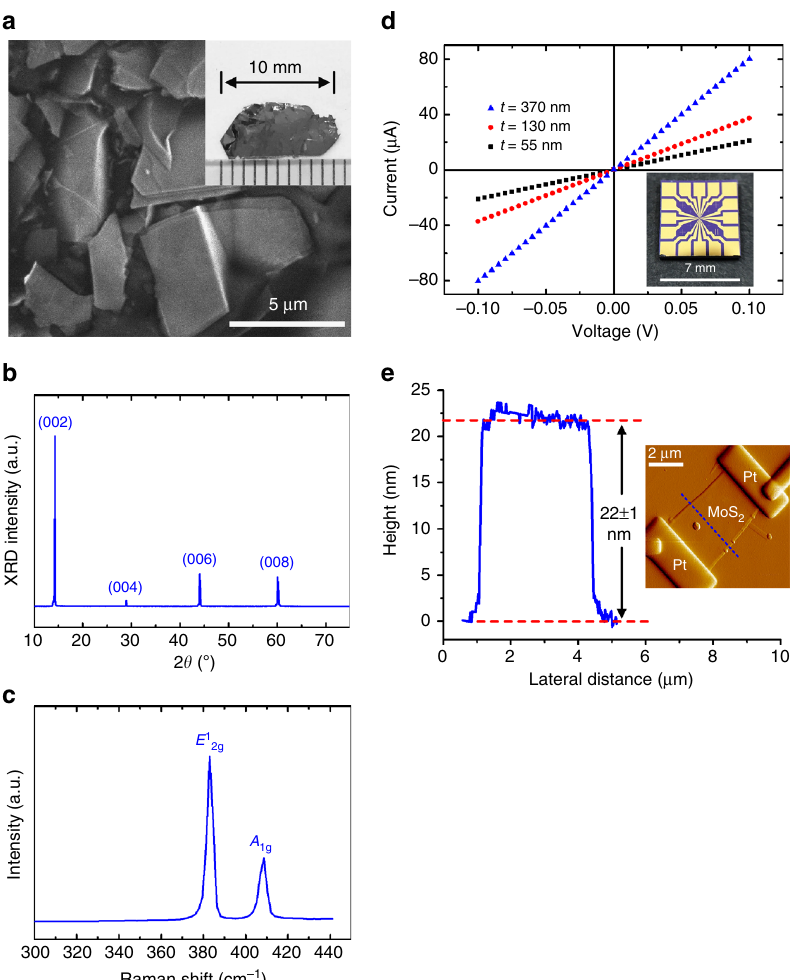
Fig. 1 Characterization of CVT-grown MoS 2 crystals and FIB-fabricated nano fl ake devices. a SEM image for MoS 2 fl akes after preliminary mechanical exfoliation by using dicing tape. The inset in a depicts a photo of pristine bulk crystals of MoS 2 . b XRD pattern and c Raman spectrum for MoS 2 bulk crystals grown using the CVT method. d I – V curves measured using the two-probe method for MoS 2 nano fl akes with different thicknesses. The inset in d depicts a chip template with patterned multiple Ti/Au electrodes used for the MoS 2 nano fl ake device fabrication by FIB. e The height pro fi le and image of an AFM measurement of a MoS 2 nano fl ake with a thickness of 22